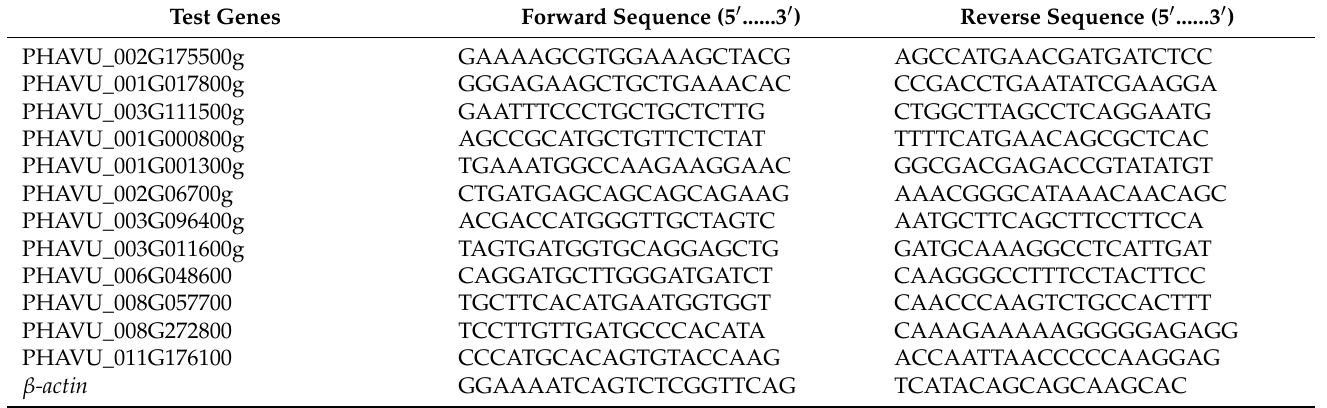
Table 1. Primers for plant defense genes JA, SA, and ET. Test